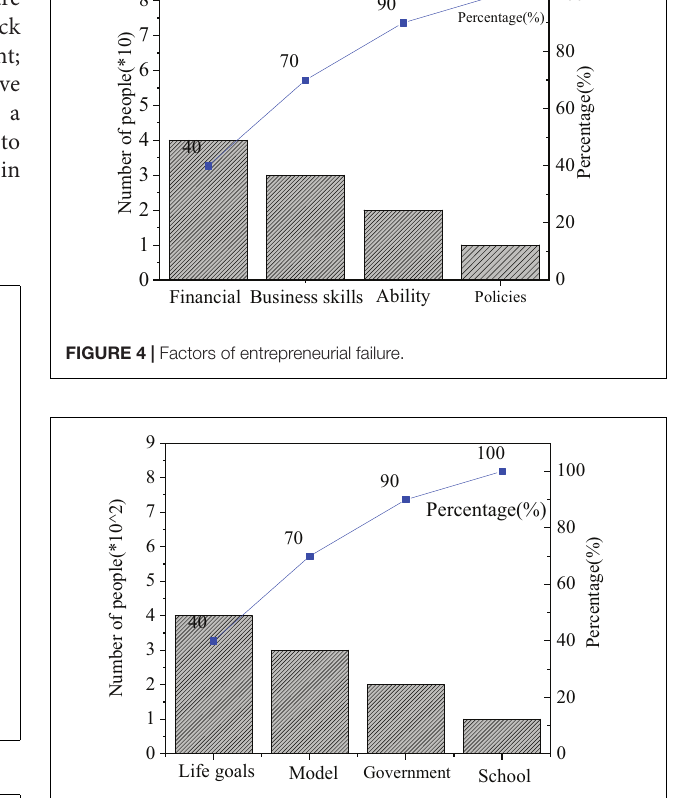
FIGURE 5 | Factors influencing entrepreneurial values.